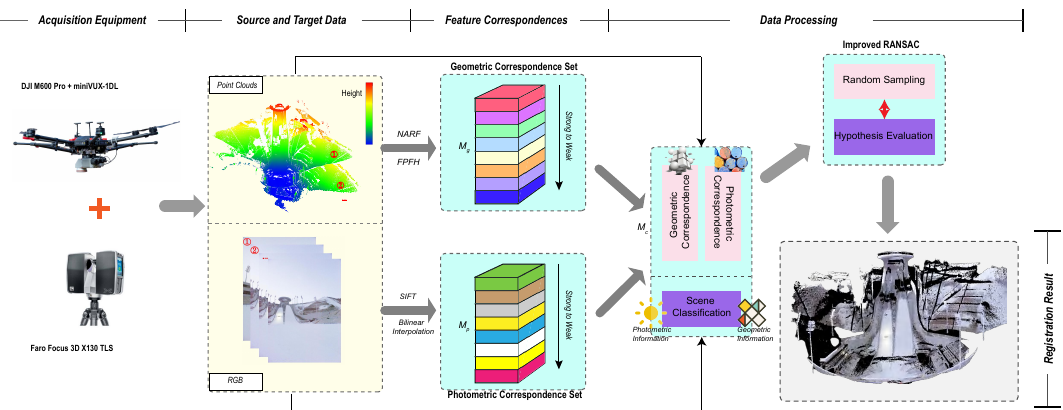
Figure 3. System workflow diagram. The system consists of four main components: (1) Data acquisition. As well as the drone-borne Lidar system and the TLS system, we also obtain data from third-party sources, such as Semantic 3D; (2) Data type. The data packages used include point cloud datasets and RGB image sets. There are different colors in the gradient bar ( ) in the point cloud dataset that represent different altitudes; (3) Feature matching point pairs. A mixed feature pair point set is established through geometric matching and photometric matching; (4) Data